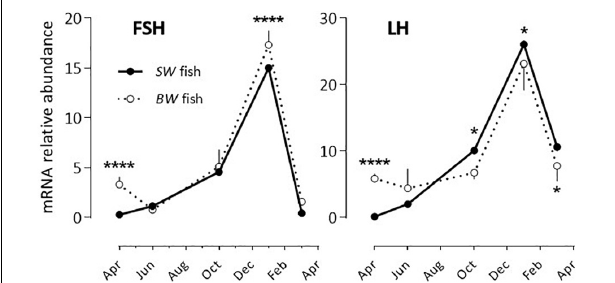
FIGURE 1 | Relative annual variations in FSH and LH mRNA abundance in sea bass pituitaries in vivo . The pituitaries were collected from April until March of the following year. As detailed in the Materials and Methods section each value represents the mean ± S.E.M. ( n = 6) of the values obtained from the